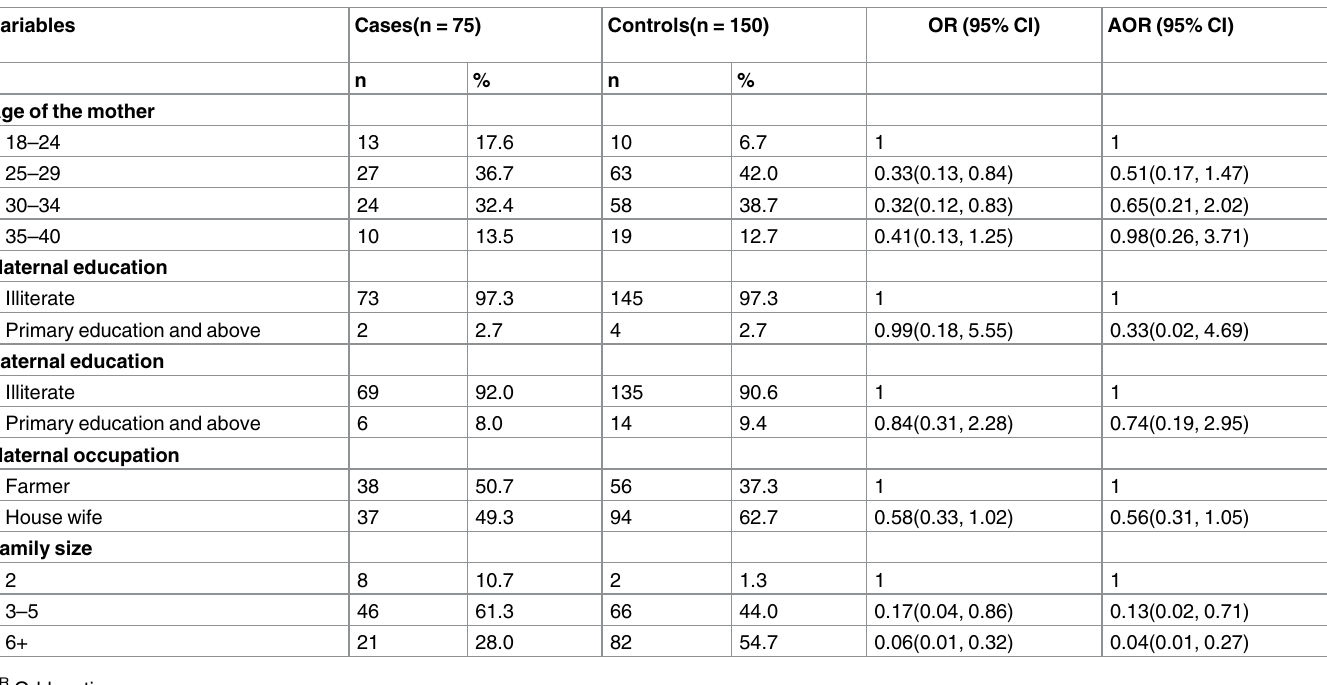
In this study, we found a significantly lower neonatal mortality rate compared to the national and Amahra Regional State estimates. Newborns in a family of two had a higher odd of death in the neonatal period as compared to those who were born in a family of three or more. Previ- ous history of neonatal mortality and number of delivery (parity) were independently associ- ated with neonatal death. Table 3. Socio-economic and demographic factors associated with neonatal mortality, West Gojam zone, Feb 2012 (n = 225).